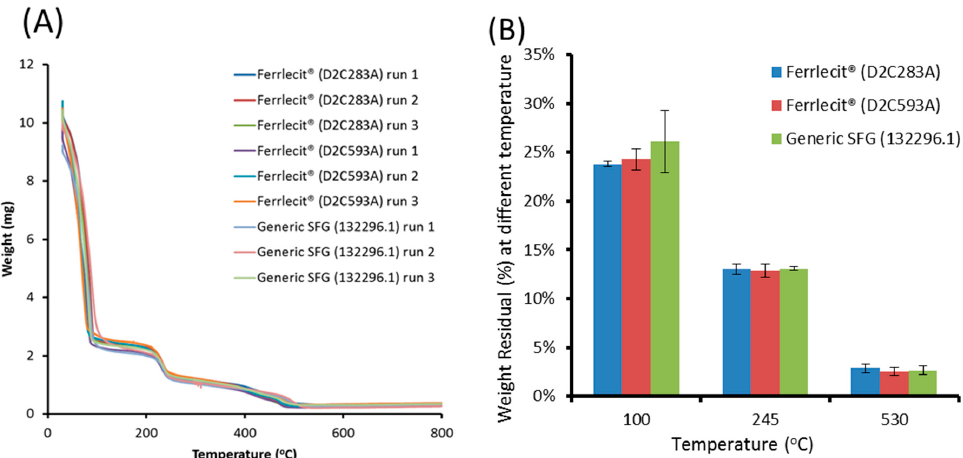
Figure 1. ( A ) Thermogravimetric diagrams of three independent runs of two Ferrlecit lots (D2C283A and D2C593A) and one generic SFG lot (132296.1) and ( B ) the average percentages and standard deviation ( n = 3) of their weight residues at 100, 245 and 530 °C.